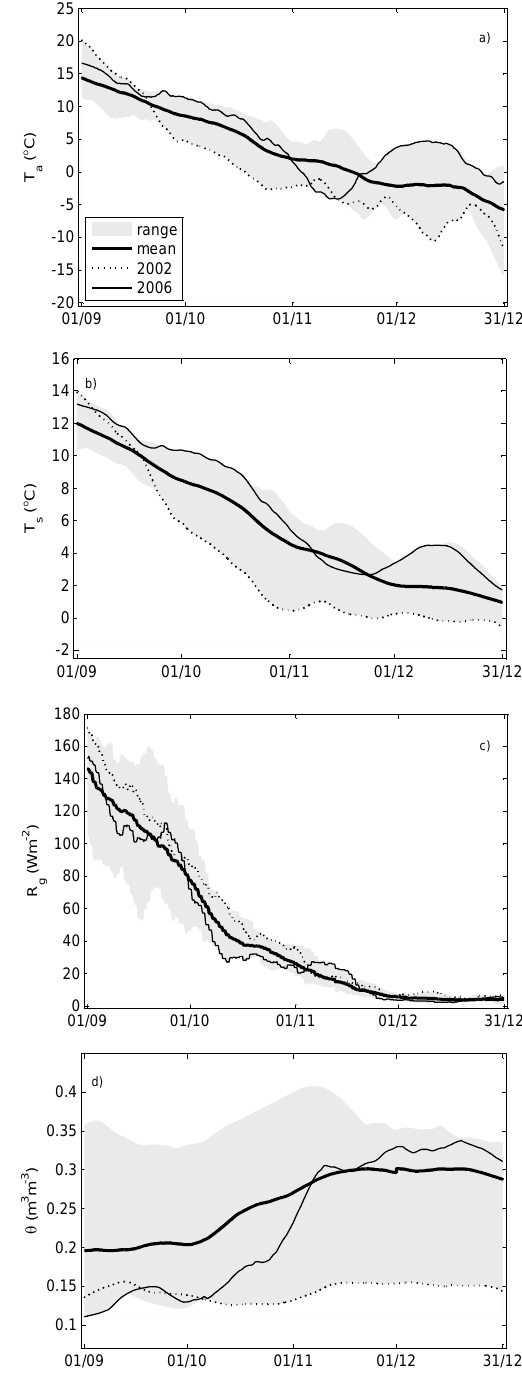
Fig. 2. The climate conditions. (a) air temperature ( T a ), (b) soil temperature ( T s ), (c) global radiation ( R g ) and (d) volumetric soil water content ( θ ). The average and the extreme years (2002 and 2006) are shown separately and the shaded area shows the variabil- ity range during 1997–2007. All values are 14-day running aver-